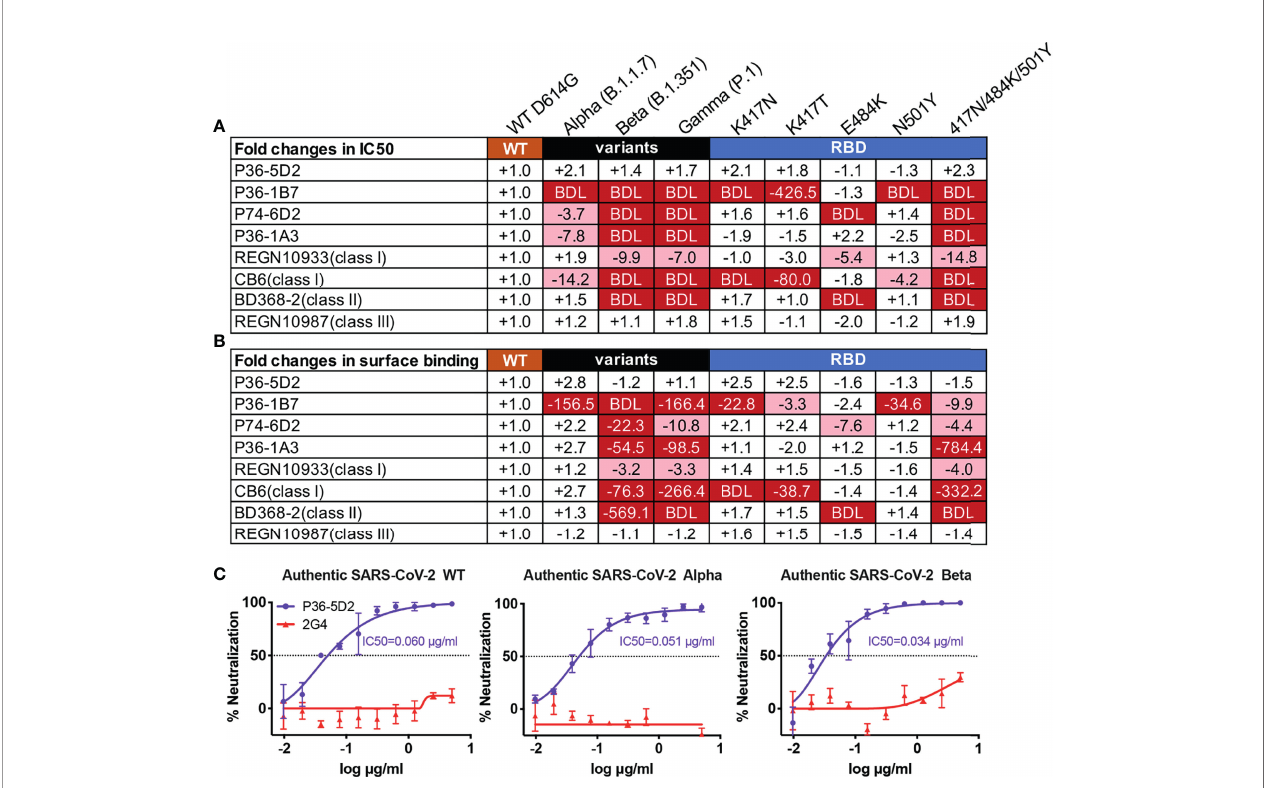
FIGURE 1 | P36-5D2 shows broad and potent neutralizing and binding spectrum against pseudotyped and infectious SARS-CoV-2. P36-5D2, P36-1B7, P74-6D2, and P36-1A3 were the top 4 isolated neutralizing monoclonal antibodies (mAbs) against severe acute respiratory syndrome coronavirus 2 (SARS-CoV-2) from infected individuals. Published representative receptor-binding domain (RBD)-speci fi c mAbs included REGN10933 (class I), CB6 (class I), BD356-2 (class II), and REGN10987 (class III). The neutralizing and binding ability of mAbs against pseudotyped SARS-CoV-2, including Alpha (B.1.1.7), Beta (B.1.351), and Gamma (P.1), and the respective mutations derived from the three variants of concern (VOCs) were evaluated. Values indicate the fold changes in half-maximal inhibitory concentrations (IC 50 ) (A) and the mean fl uorescence intensity (MFI) relative to that of wild-type (WT) D614G (B) . The IC 50 of antibodies against WT D614G are listed in (A) . The minus symbol represents increased resistance and the plus sign indicates increased sensitivity. IC 50 or MFI highlighted in red indicates that resistance increased at least threefold; in blue , sensitivity increased at least threefold. BDL (below detection limit) represents the highest concentration of mAbs that failed to reach 50% potency in neutralization activity or mAbs that failed to bind the cell surface-expressed SARS-CoV-2 variants. Results are presented as the mean value from three independent experiments. (C) Neutralization of P36-5D2 against the infectious SARS-CoV-2 WT, Alpha, and Beta variants. 2G4 is the negative control antibody speci fi c for Ebola virus glycoprotein (EBOV GP). Experiments were performed in triplicate, and all data were presented as the means ±